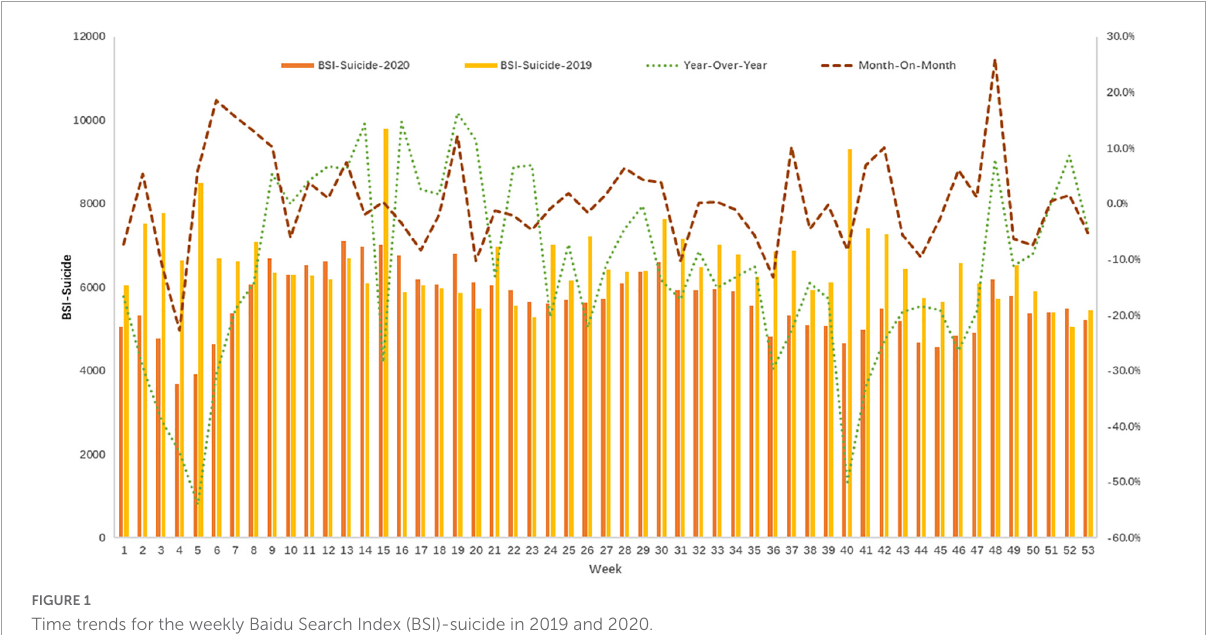
FIGURE1 Time trends for the weekly Baidu Search Index (BSI)-suicide in 2019 and 2020.